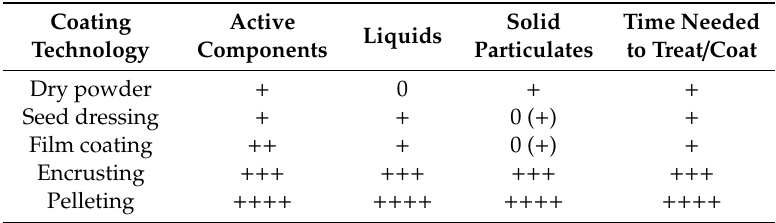
Table2. Comparisonofamountofcoatingcomponentsandtimeneededforthedrycoating, seeddressing, film coat, entrustment and seed pellet technologies. The ( + ) for seed dressing and film coating is the addition solid particulates as finishing powders. Relative comparisons are noted with number ‘ +